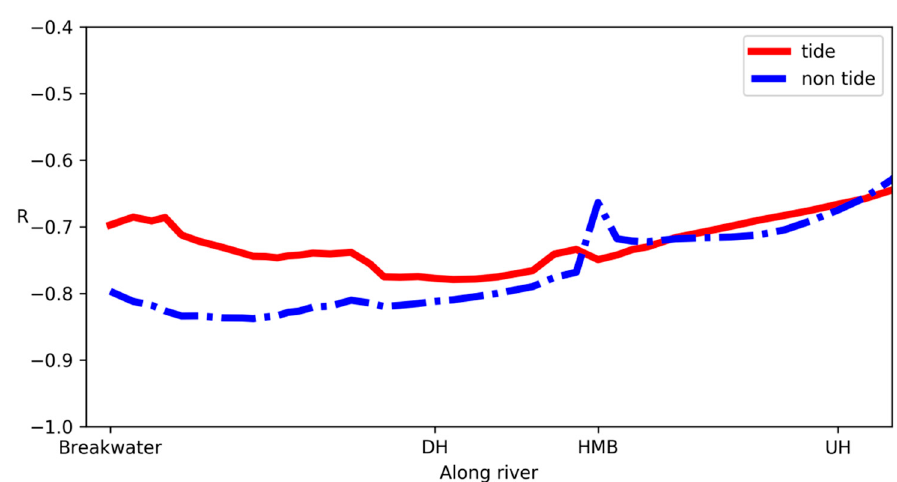
Figure 9. The correlation between salinity and ammonia nitrogen along the river from breakwater until the UH cross-section. The R values of the tide and non-tide-receiving scenarios are plotted in red and blue, respectively. P values are lower than 0.01. Table 2. Seaward flux of ammonia and water mass at the cross-section of HMBand breakwater in both scenarios for a lunar cycle in the spring / neap phase and for a spring–neap